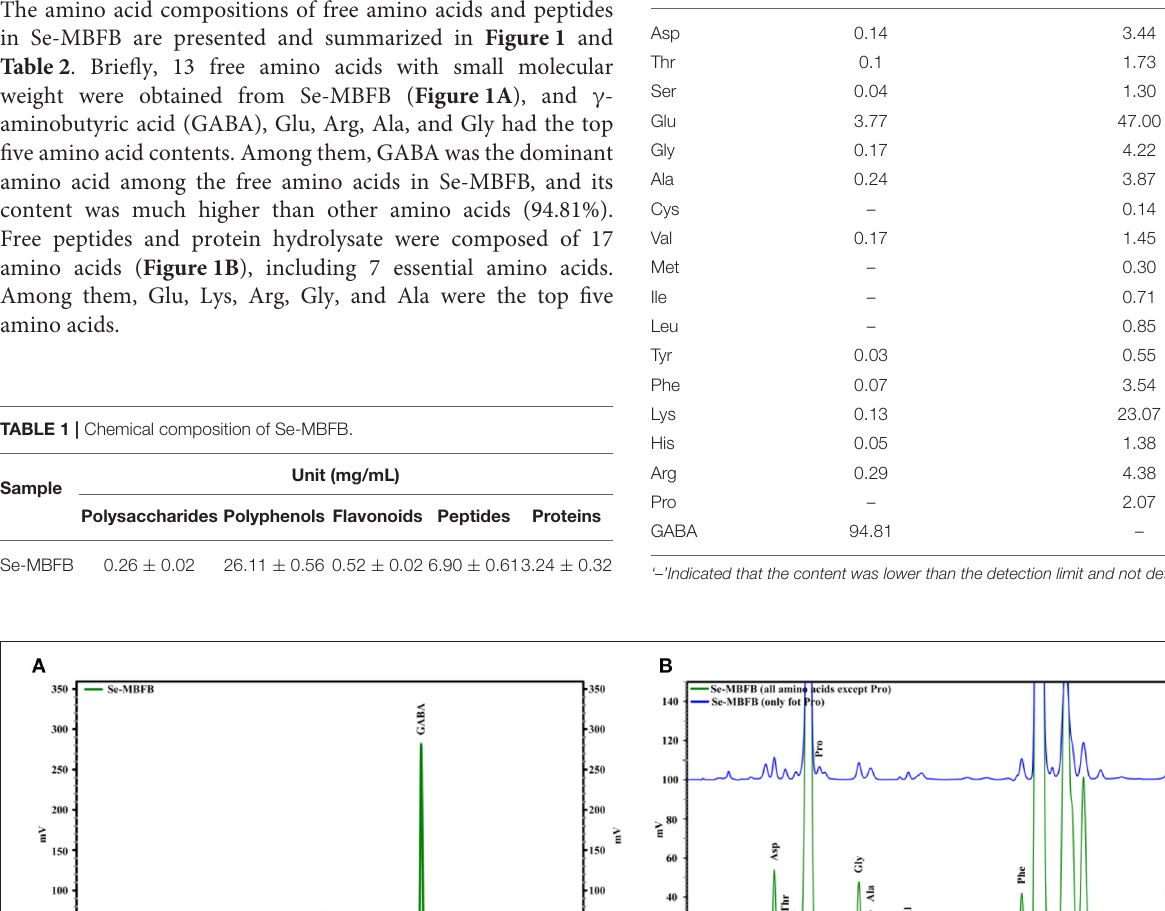
Frontiers in Nutrition |